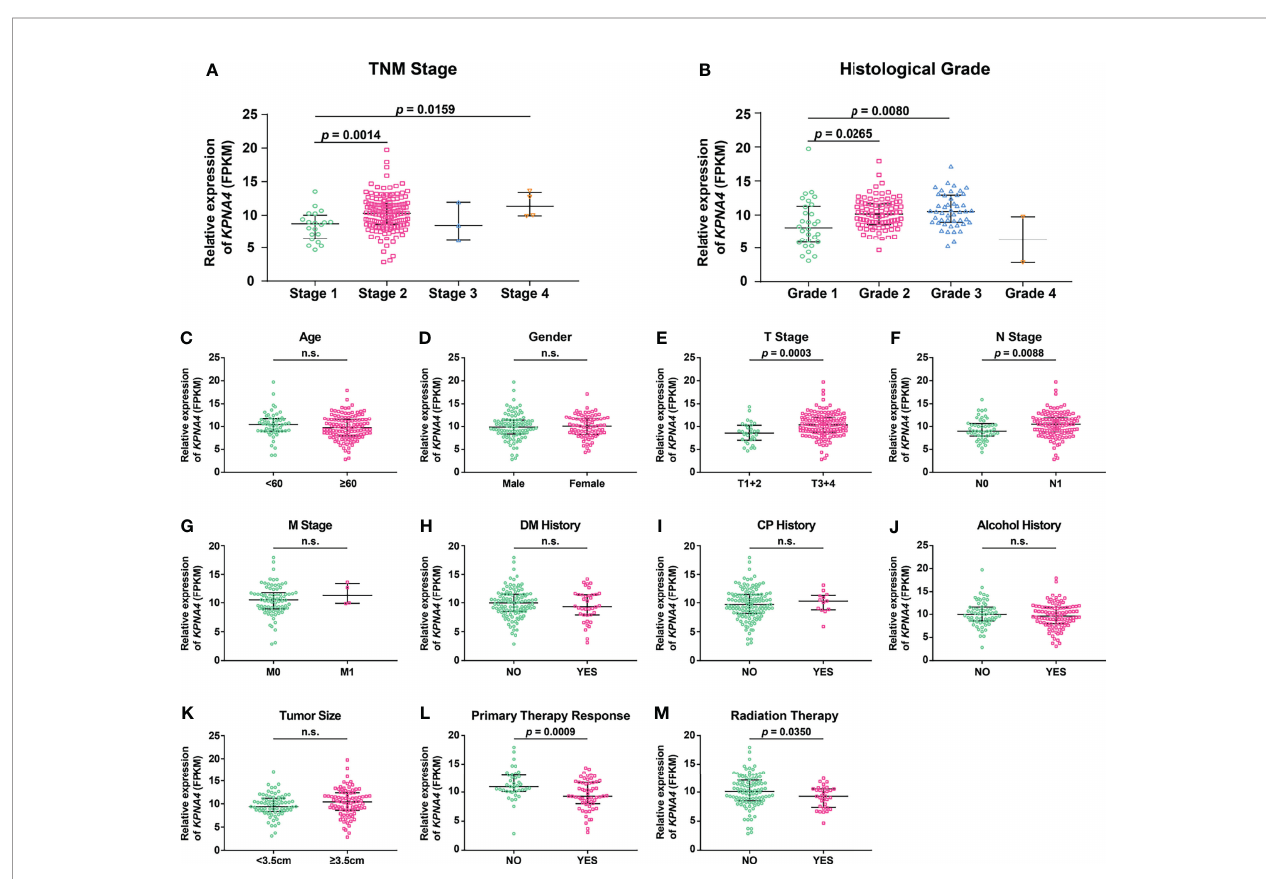
FIGURE 2 | Association of KPNA4 expression with clinicopathologic characteristics of PDAC patients. KPNA4 expression in PDAC samples with different TNM stages (A) and histological grades (B) . TCGA PDAC samples with clinical data were used to analyze the correlation of KPNA4 expression with other clinicopathologic parameters (C – M) . p -value < 0.05 was regarded statistically signi fi cant. n.s., no signi fi cance.